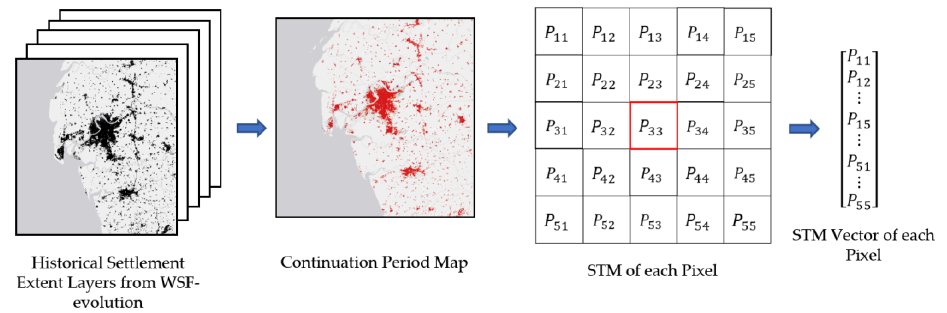
Figure 5. Workflow of generation of STM, illustrated based on a window size s w of